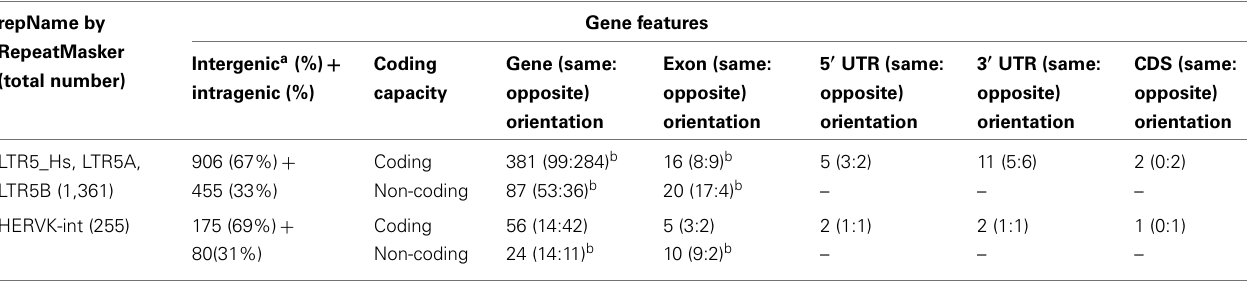
Table 2 | Location of HERV-K loci relative to human protein-coding genes and their components.